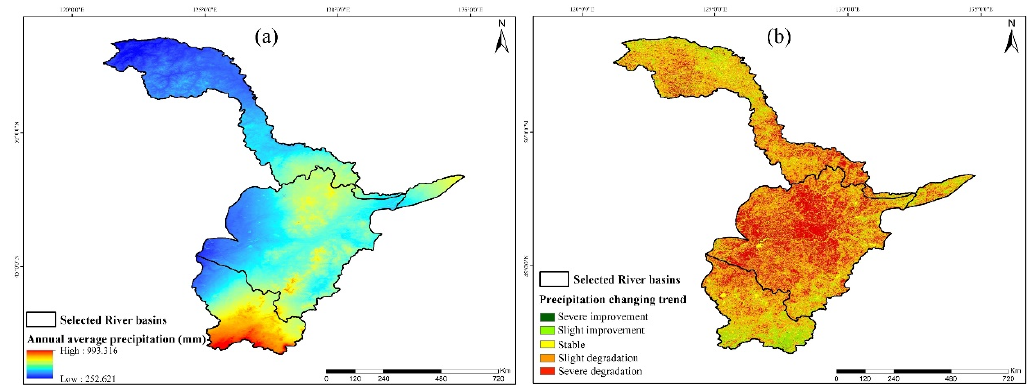
Figure 10. Spatial distribution of annual average precipitation ( a ) and changing trend of the annual precipitation ( b ) over Heilong and (Second) Songhua River basins from 2001 to 2019.